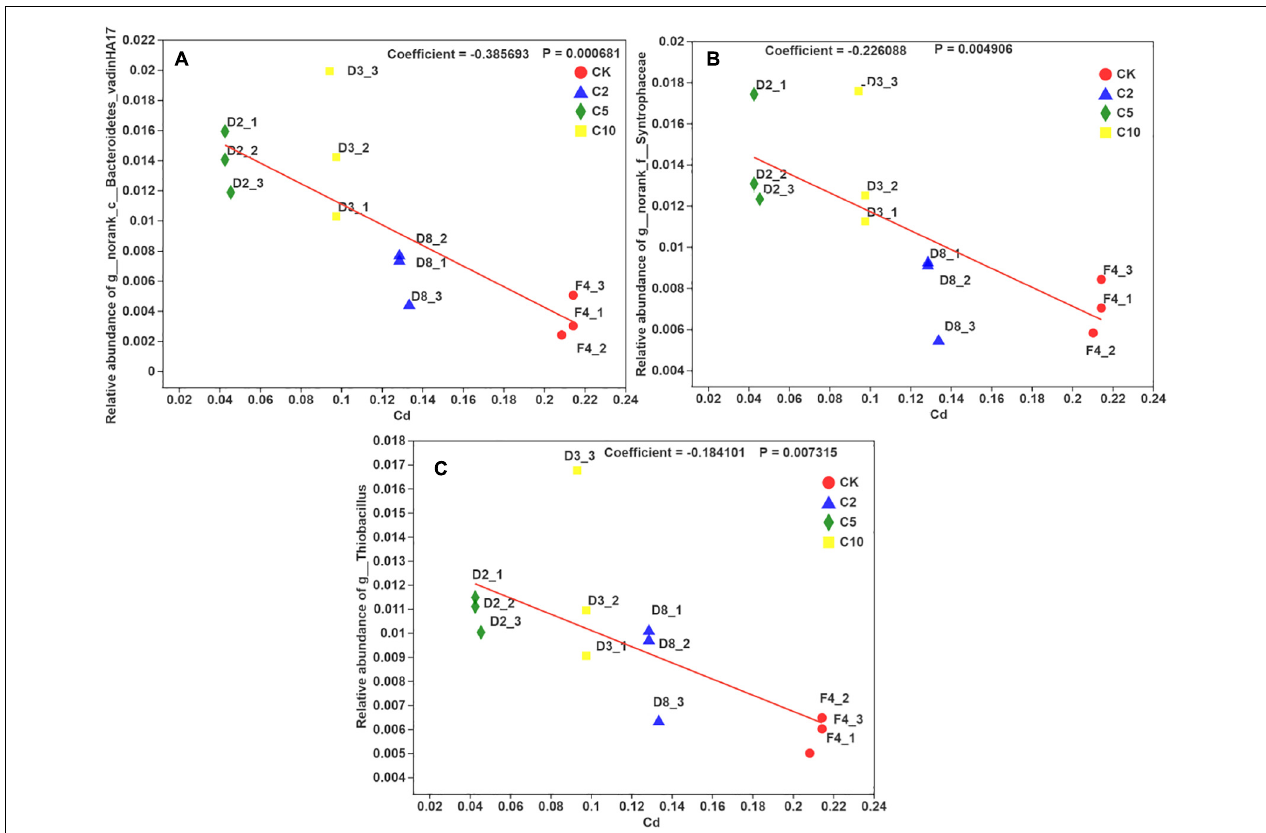
FIGURE 7 | The multivariate association with linear models between the relative abundance of three microorganisms (A–C) in the genus level and available Cd concentration in soil with different amendment